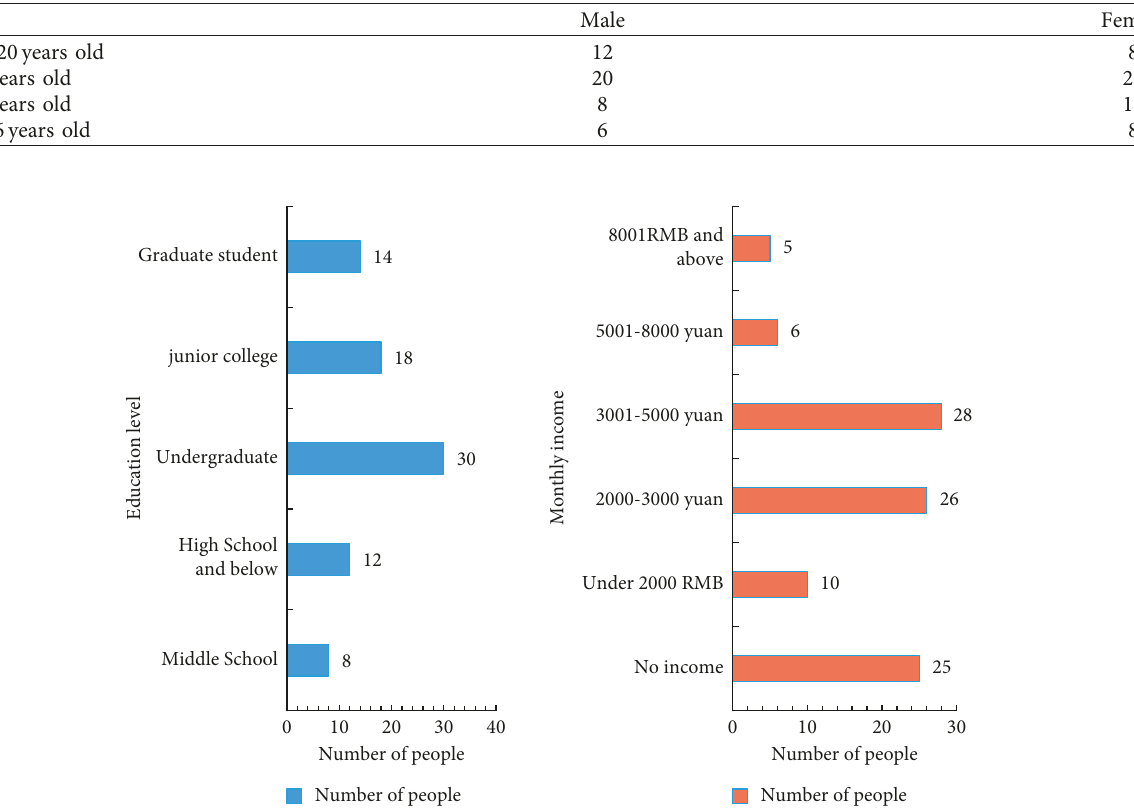
Figure 7: Respondents’ educational background and monthly